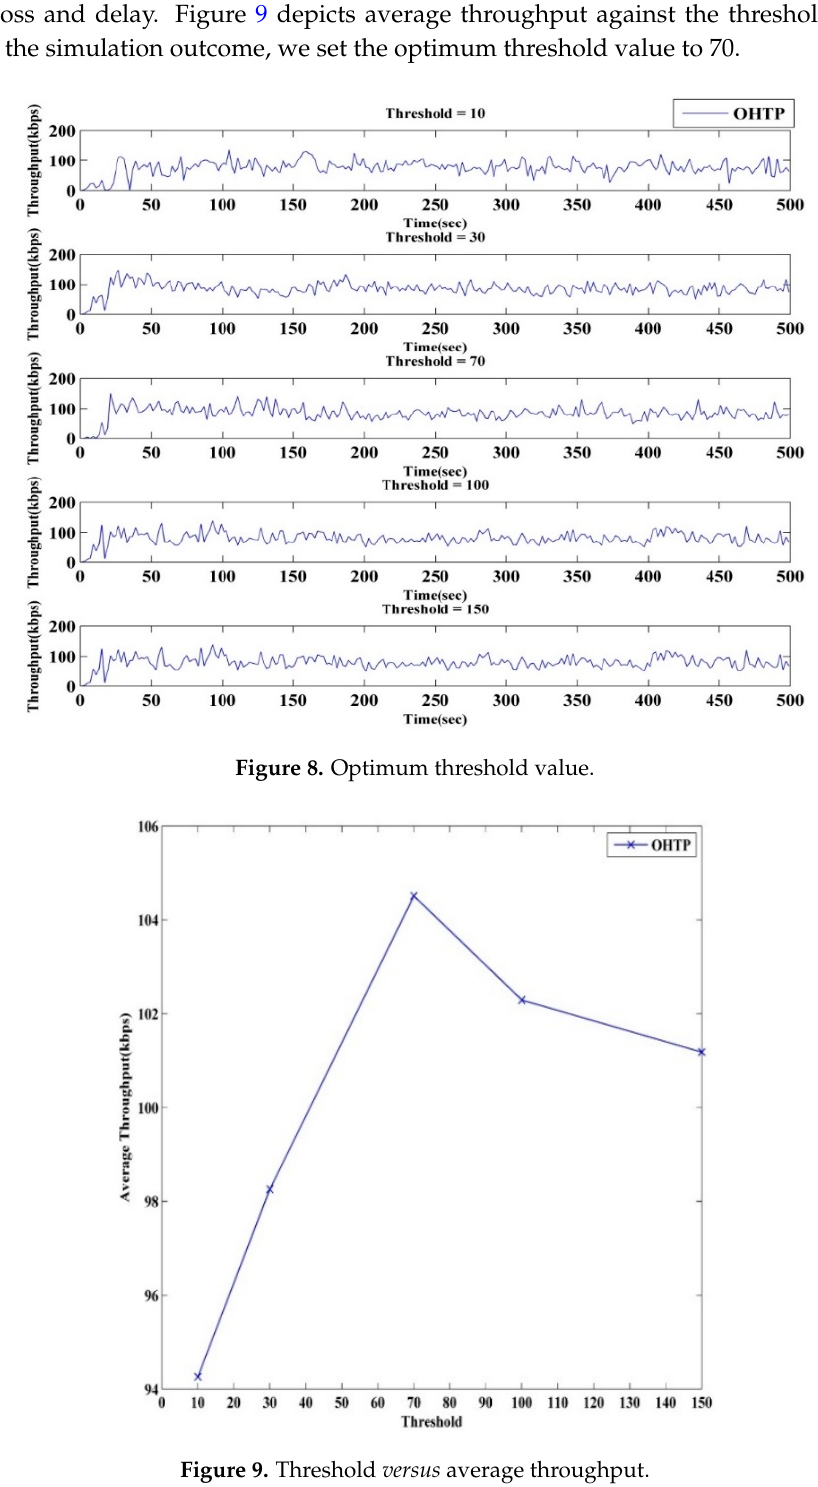
Figure 9. Threshold versus average throughput.